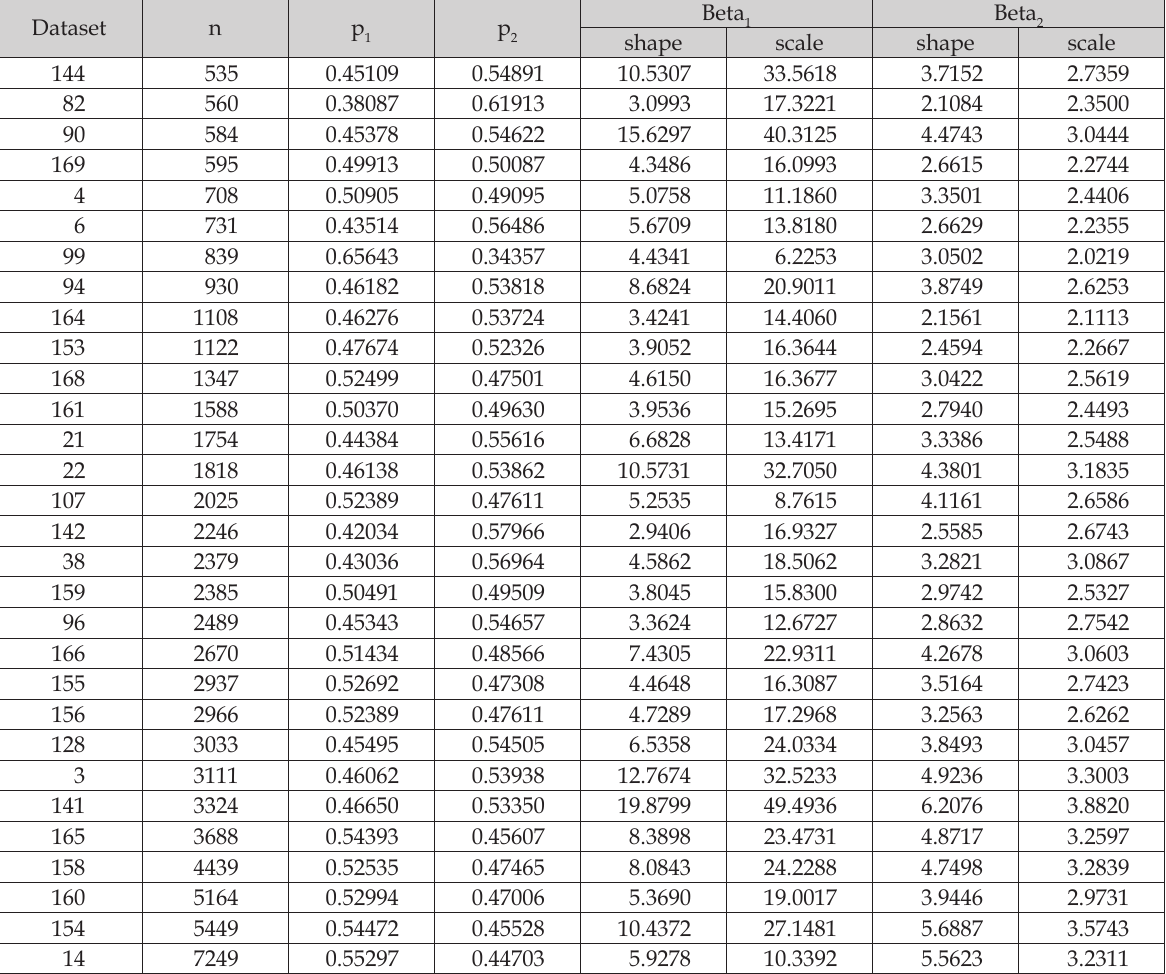
Table 1. Two-beta mixture estimates for describing eigenvalue frequency distributions for irregular